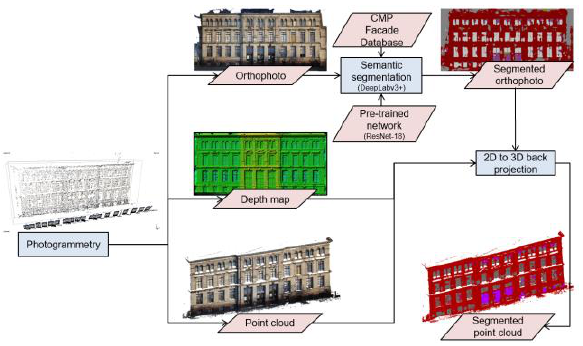
Figure 1. General workflow of the developed